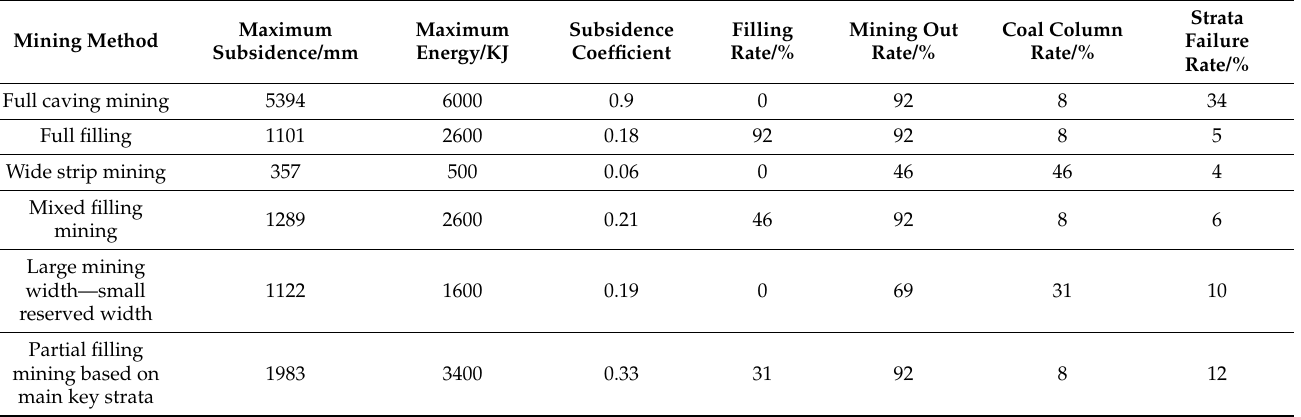
Table 14. Statistics on maximum surface subsidence and maximum energy polling distribution under different mining